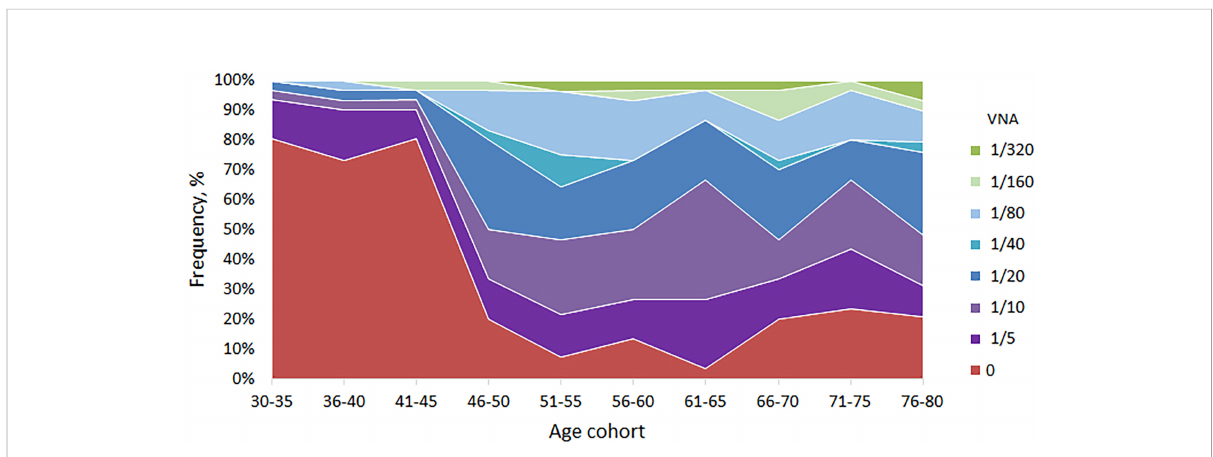
FIGURE 2 VNA in different age cohorts. The frequency of samples with VNA = 0 drops sharply in age cohorts older than 45 years. For people younger than 45 years old, the proportion of people with VNA ≥ 1/20 titer ranged from 3.2 to 6.7%, and for people older than 45 years old – from 33.3 to